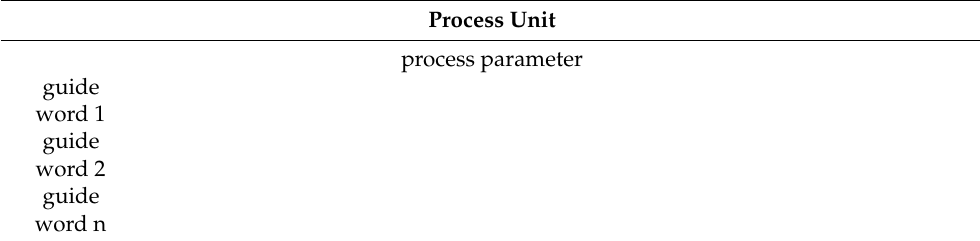
Table 1. Relevant Deviations Matrix (RDM) scheme.